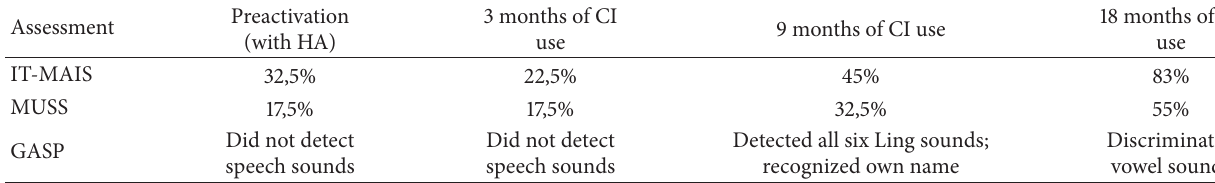
Table 2: Behavioral results at the four assessments.